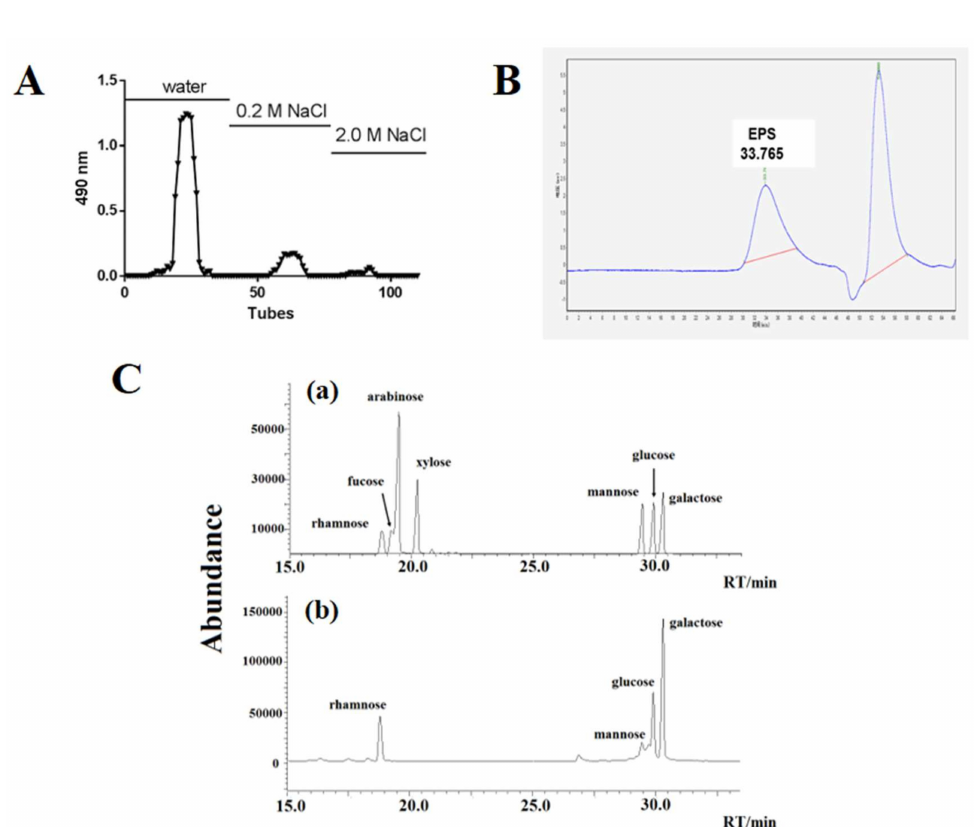
Figure 1. Isolation, molecular mass determination and monosaccharide composition of EPS from S. thermophilus MN-BM-A01. ( A ) Crude EPS separation profile by anion-exchange chromatography of DEAE Sepharose Fast